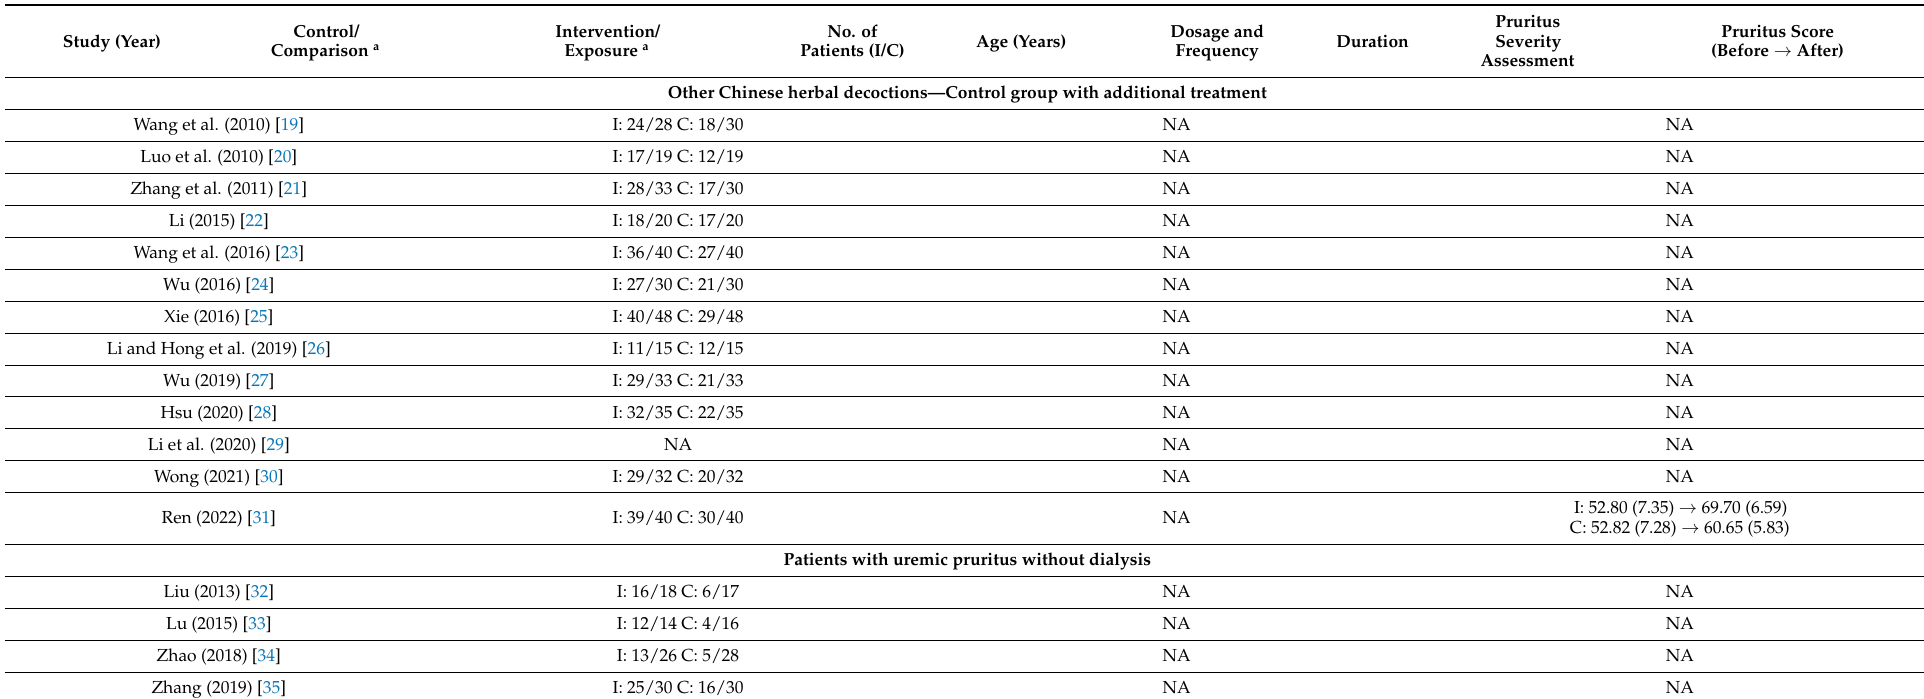
Dosage and Frequency Duration